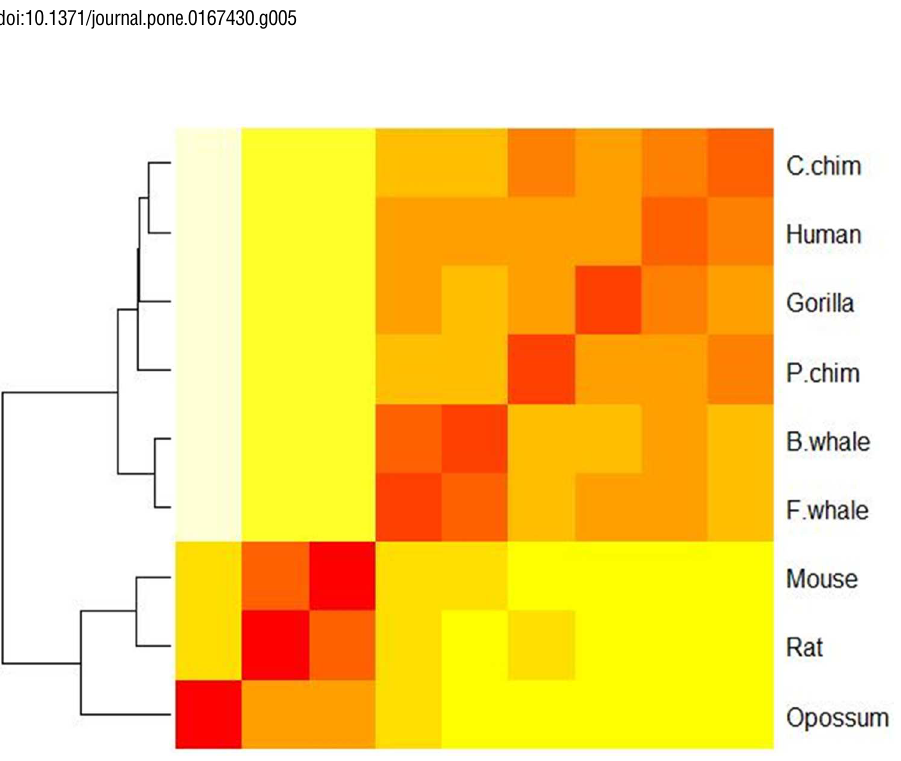
Fig 6. A heat map showing the similarity of nine species in the ND5 dataset based on the 40-D amino acid position ratio and content ratio